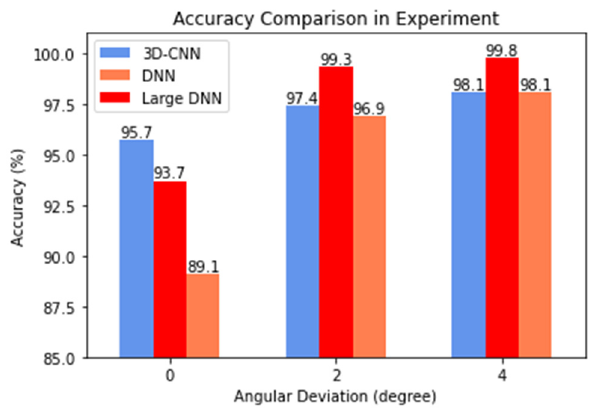
Figure 10. Accuracy of two-target DoA estimation vs. angular deviation.